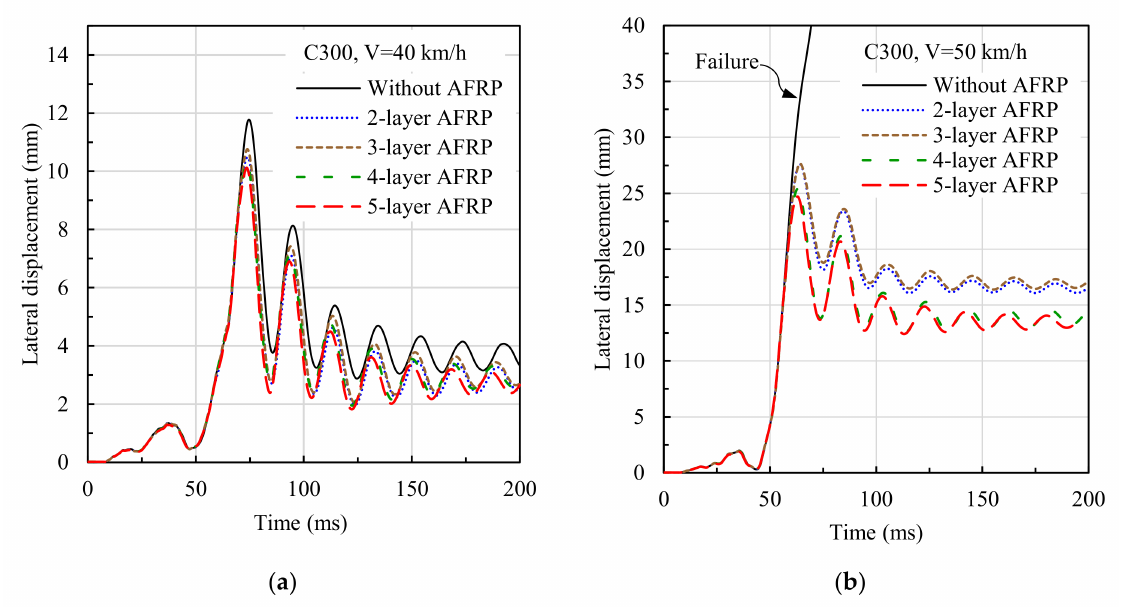
Figure 18. Displacement history of AFRP-retrofitted column C300: ( a ) car impact velocity of 40 km/h; ( b ) car impact velocity of 50